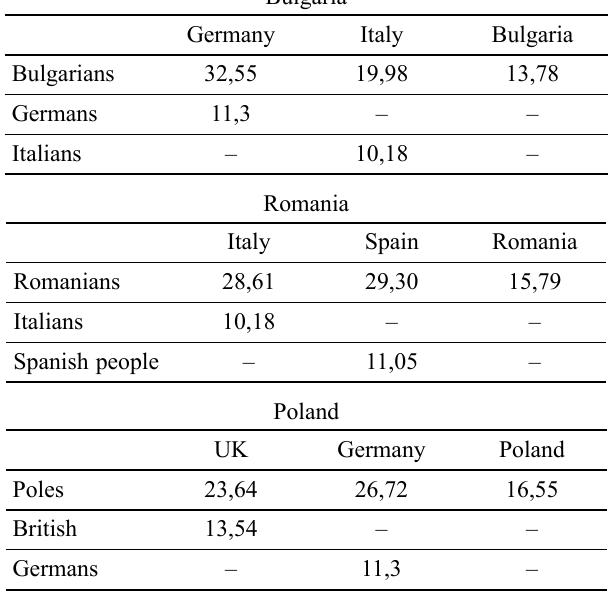
Table 2. Percent of EU 8+2 citizens, from 25 to 34 years living in selected EU-15 countries comparing to situation in country of origin and country of